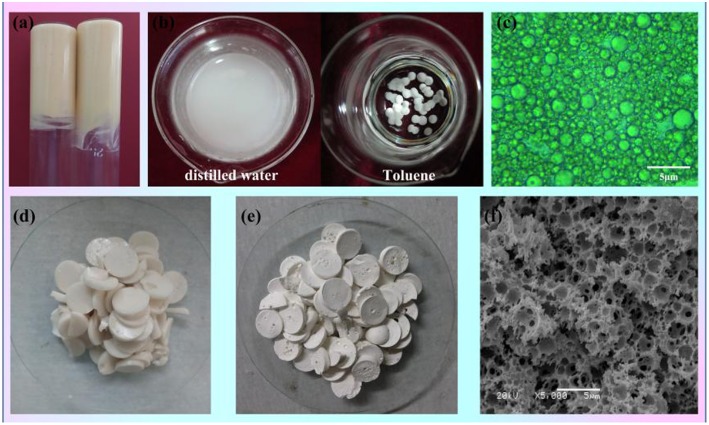
(a) Digital photographs of the prepared Pickering MIPEs (MMT, 5%;T-20, 4%; internal phase volume, 50%). (b) Testing the type of emulsion by dropwise adding the emulsion droplet into the distilled water (DI) or toluene. (c) Optical images of the Pickering MIPEs. (d) Digital photographs of CMC-g-PAM/MMT before Soxhlet extraction. (e) Digital photographs and (f) SEM of porous CMC-g-PAM/MMT.